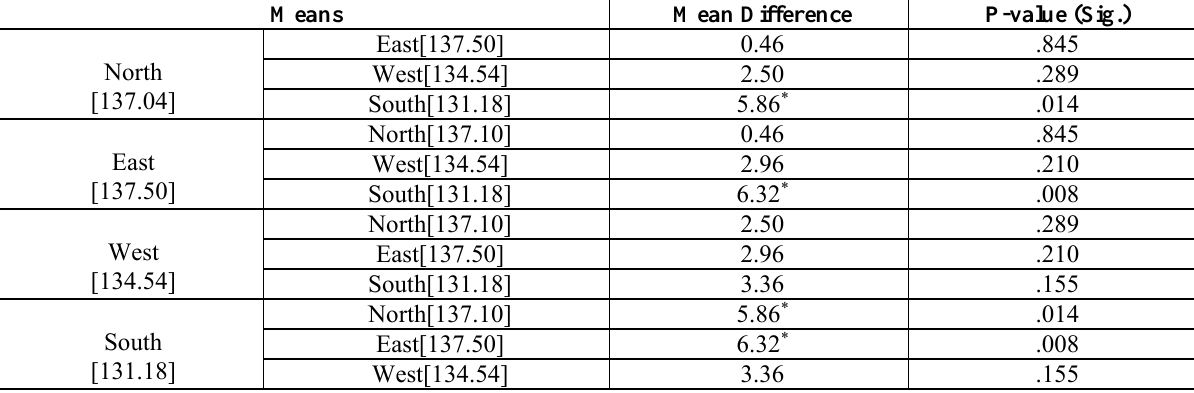
Emotional Intelligence (Total) Means Mean Difference P-value (Sig.)